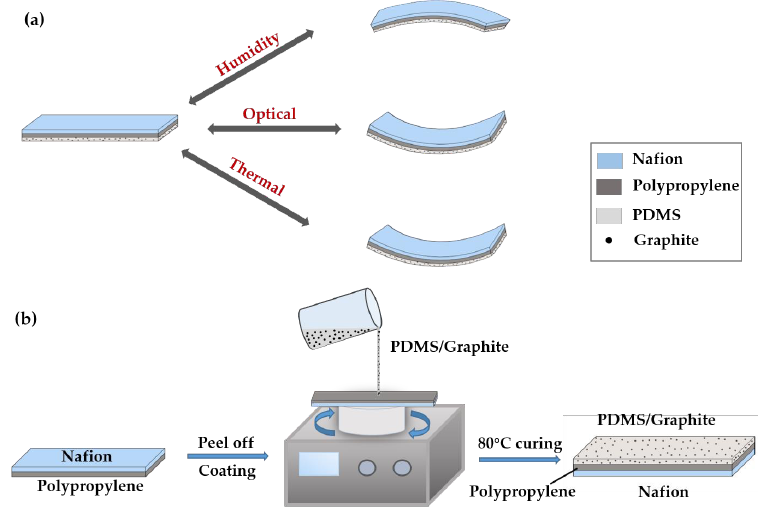
Figure 1. ( a ) Schematic diagram of multilayer membrane response to humidity, optical and thermal stimulation. ( b ) Schematic illustration of the fabrication of Nafion-polypropylene-PDMS/Graphite multilayer membrane actuator.